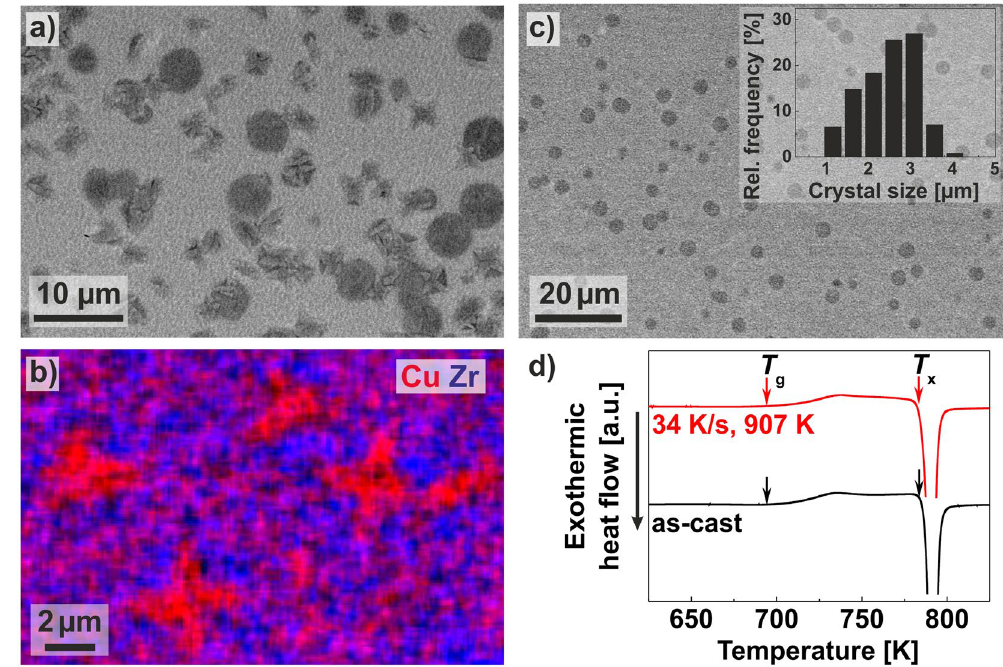
Figure 5. Microstructure of Cu-Zr-based BMGs flash-annealed to temperatures above T x . ( a ) SEM-image of a Cu 46 Zr 46 Al 8 BMG flash-annealed at ϕ ave = 34 K/s to T ej = 903 K. The microstructure consists of Cu 10 Zr 7 crystals with a dendritic shape, spherical B2 CuZr particles and a glassy matrix. ( b ) The corresponding EDX map proves the presence of the Cu-rich Cu 10 Zr 7 dendrites. Their immediate surroundings are enriched in Zr. ( c ) SEM-image near the surface of a glassy Cu 44 Zr 44 Al 8 Hf 2 Co 2 rod, which was flash-annealed at ϕ ave = 41 K/s to T ej = 907 K. Only spherical B2 CuZr particles are embedded in the amorphous matrix and the inset depicts the crystal size distribution. ( d ) DSC curves of the flash-annealed Cu 44 Zr 44 Al 8 Hf 2 Co 2 specimen and the respective as-cast specimen show the glass transition ( T g ) as well as crystallization ( T x ).